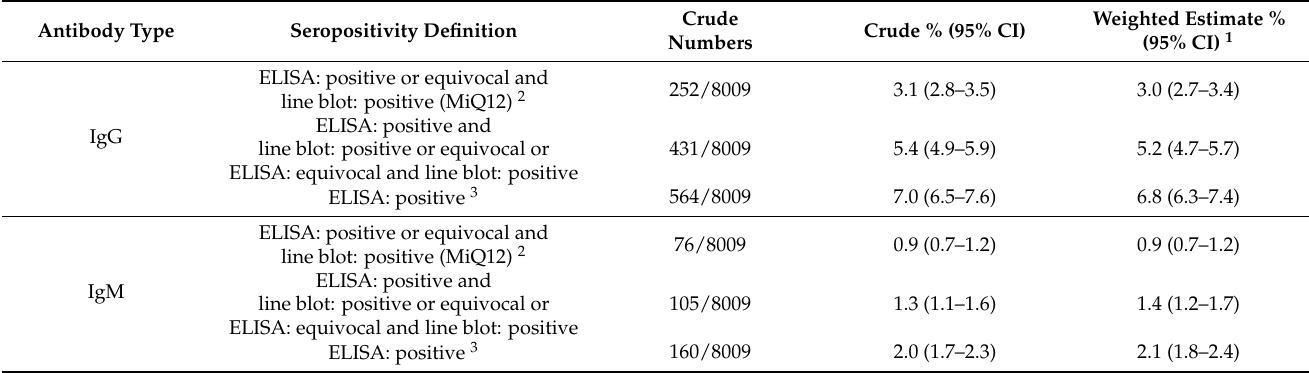
Table 2. Total crude and weighted seropositivity for Borrelia burgdorferi s.l. by three seropositivity